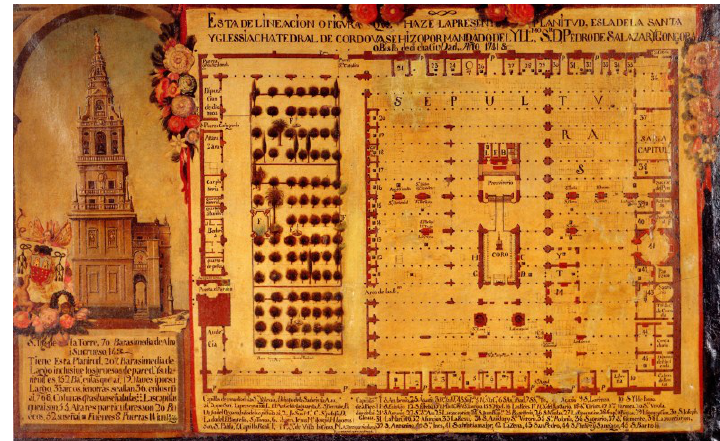
Figure 5. Current floor plan of the Mosque-Cathedral. 1741. © Cabildo Catedral de Córdoba.